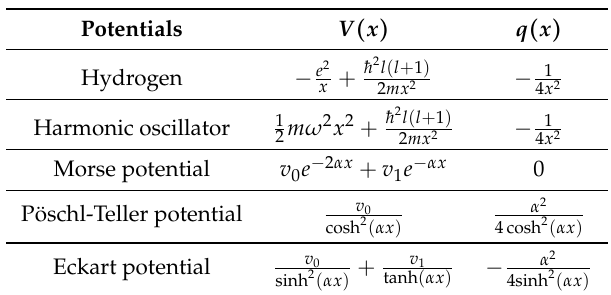
Table 1. Some exactly solvable potentials and the choices of q ( x ) . The exact energy eignvalue spectra for these solvable potentials can be found in